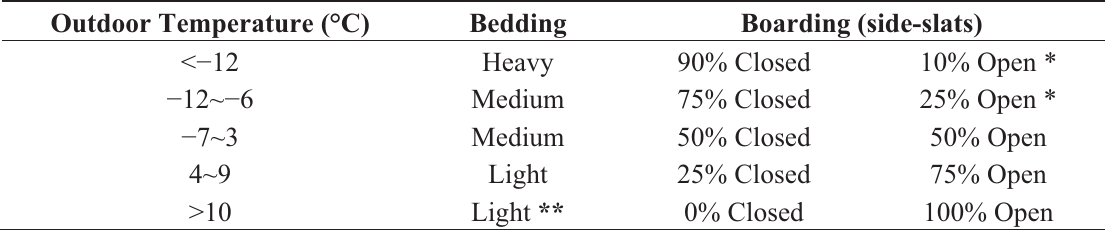
Table 1. Transport Quality Assurance (TQA) guidelines for truck setup procedures during temperature extremes for market pigs